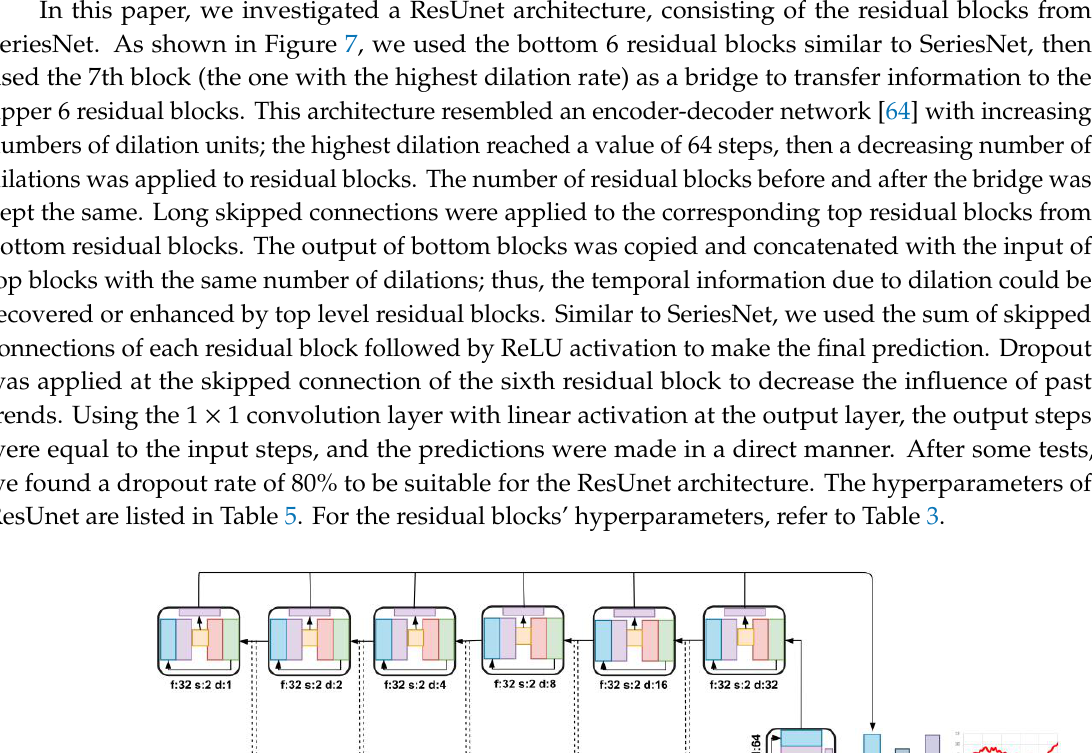
Figure 7. Residual U-Net (ResUnet) architecture for wind series time series prediction .